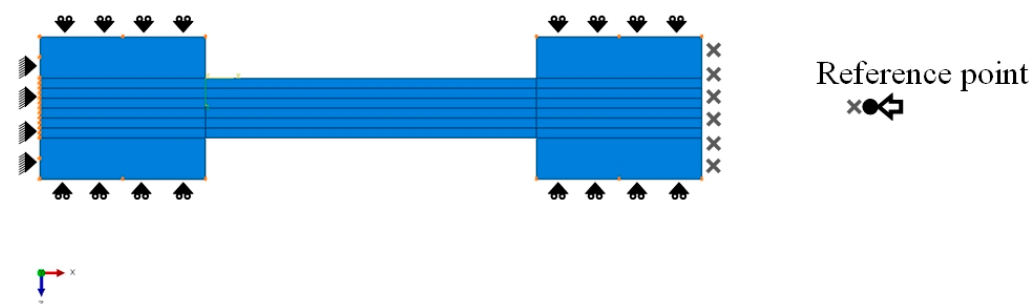
Figure 5. Boundary conditions at both ends of the sample.